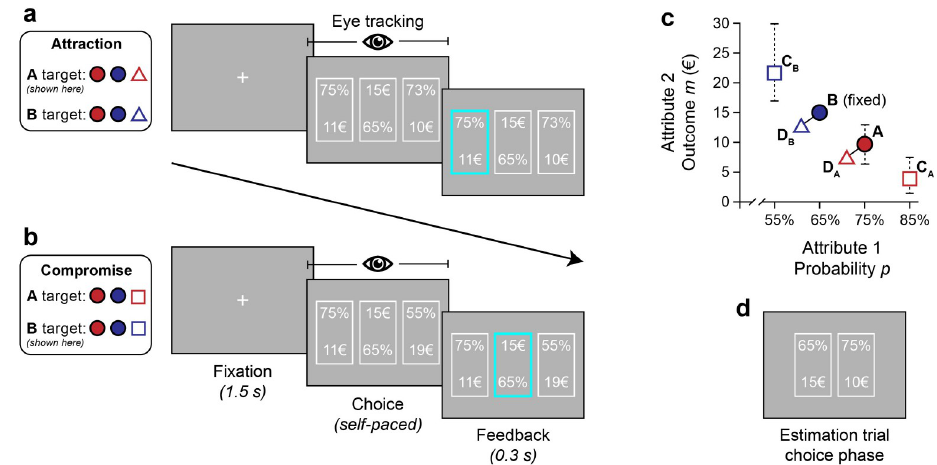
Fig 1. Choice task and attribute space of stimuli. Choice task ( a , b ). Trials started with a central fixation cross for 1.5 s. Next, three gambles were presented. Participants made a choice by button press, without time limit. Eye movements were recorded during the choice phase. Finally, brief feedback on the choice (but not on the gamble outcome) was displayed. Note that in each trial, the vertical layout of probability and outcome attributes was determined randomly for each alternative. Choice sets in attraction trials ( a ) contained core options A and B and an asymmetrically dominated decoy D (shown) or D . Compromise trials ( b ) included A , B , and a compromise decoy C or C (shown). A B A B (c) Attribute space. Each gamble is described by two attributes: Probability p and outcome m . The core options A and B were presented in every trial, along with one of four decoy alternatives: Asymmetrically dominated decoys ( D A or D B ) and compromise decoys ( C A or C B ) are expected to elicit attraction and compromise effects, respectively. Dashed , A and C were calibrated for pairwise lines indicate possible stimulus placements. (d) Exact positions for C B A indifference in separate binary choice estimation blocks for each individual. Differences in outcome between neighbouring alternatives was not less than 2 EUR. Dominated decoys D and D were always 2% and 1 EUR worse A B than A and B